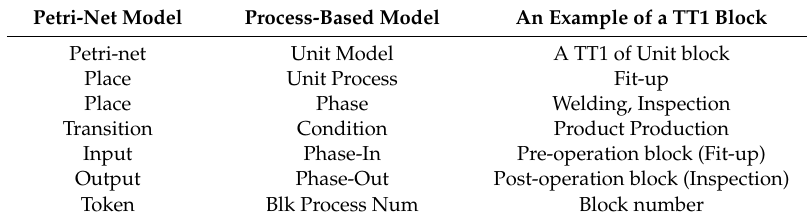
Table 3. Mapping the relationship between the process-based model and the Petri-net